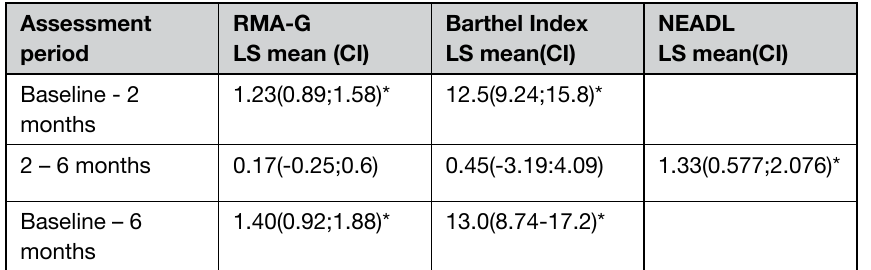
Table 4 Time effects: changes in activity limitations as measured by the RMA-G, Barthel index and eADl for different assessment